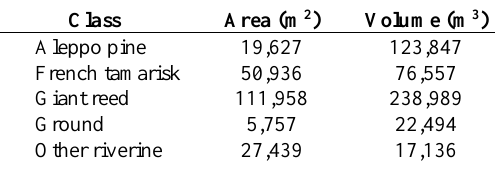
Table 4. Area and volume occupied by